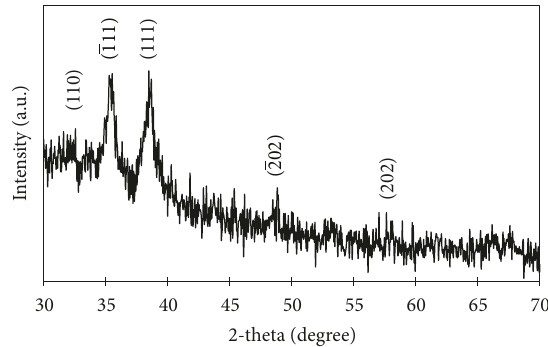
Figure 2: X-ray diffraction pattern of the obtained hybrid